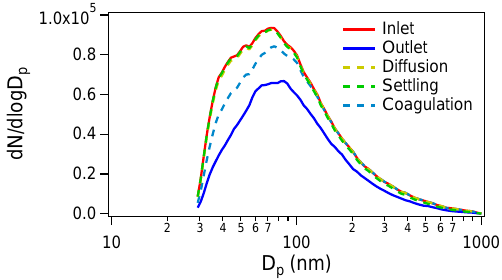
Figure 10. Particle size distributions at the outlet when diffusion, gravitational settling and coagulation processes are coupled sepa- rately with the size distribution at the inlet. The measured size dis- tribution at the outlet is plotted as a reference. The coupling of dif- fusion and gravitational settling with the inlet size distribution is the product of dashed lines and the red line in Fig. 9d. The coag- ulation process is calculated in a coagulation model, which uses a PFR model with an average residence time of 1520s by assuming a unity coagulation efficiency and no wall deposition. The coagula- tion model input is the size distribution at the